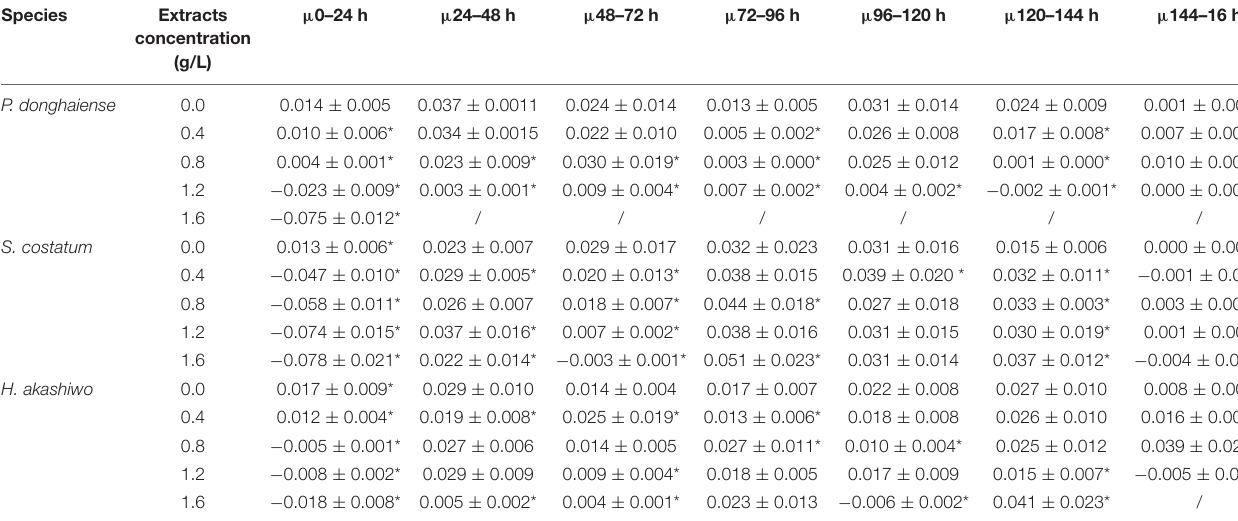
TABLE 2 | The relative growth rate of low density microalgae under the influence of different concentrations of extracts ( µ ) (h − 1 ). Species Extracts